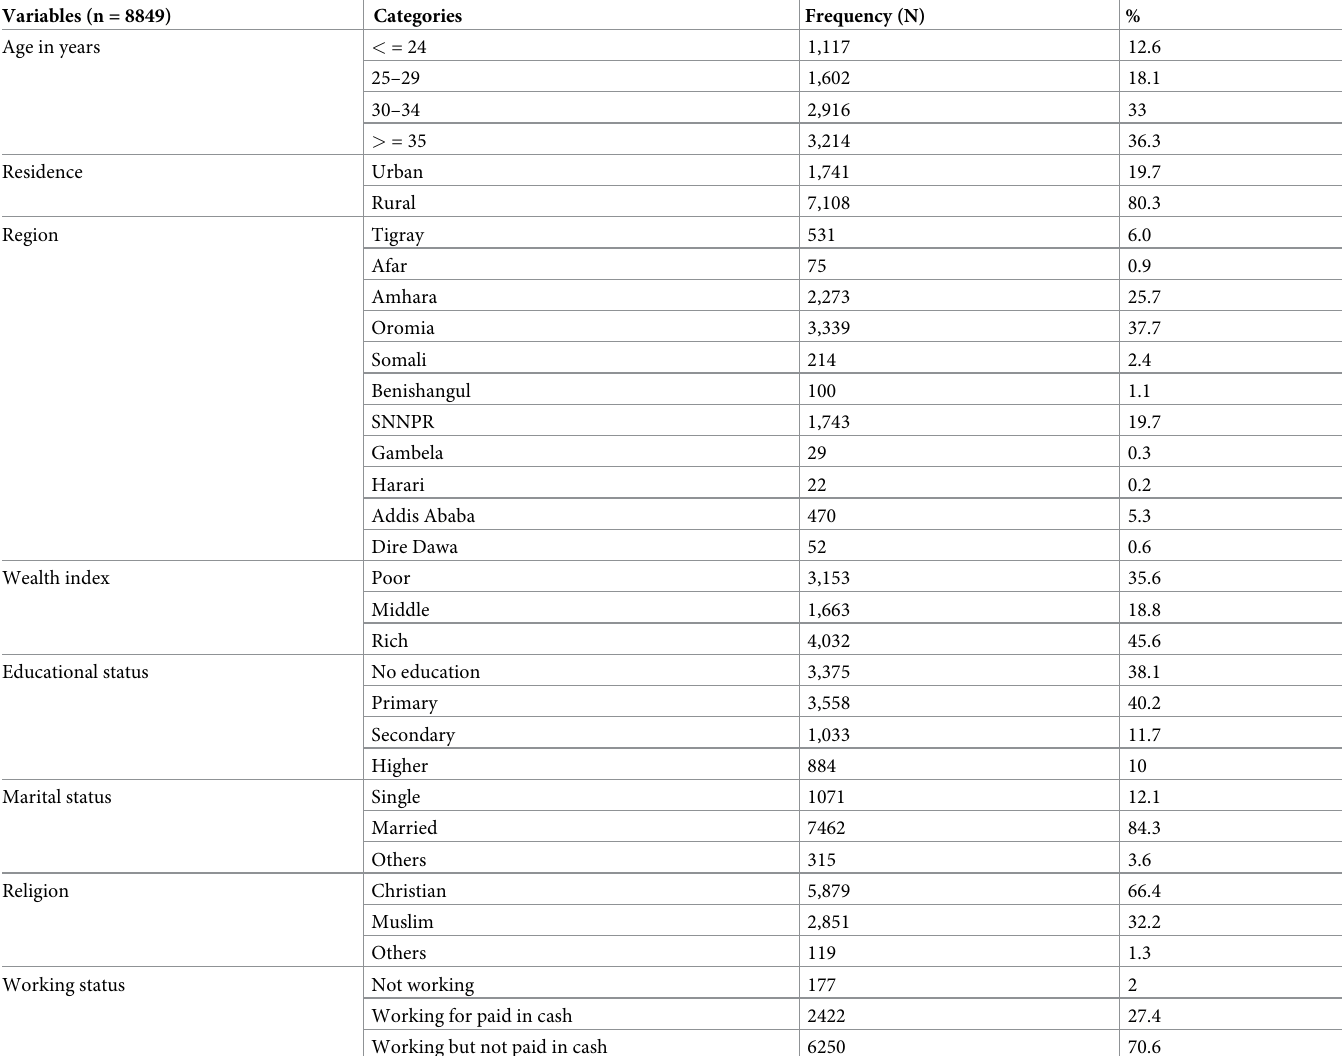
Table 1. Sociodemographic characteristics of men who were sexual-active, Ethiopia; 2016 DHS. Variables (n =